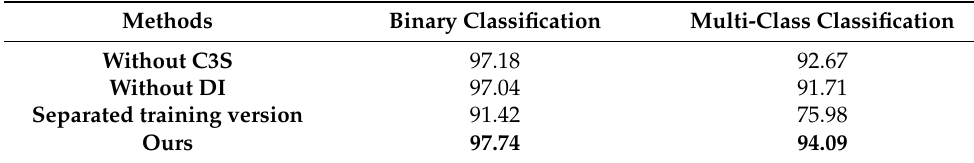
Table 6. Ablation experiment on classification